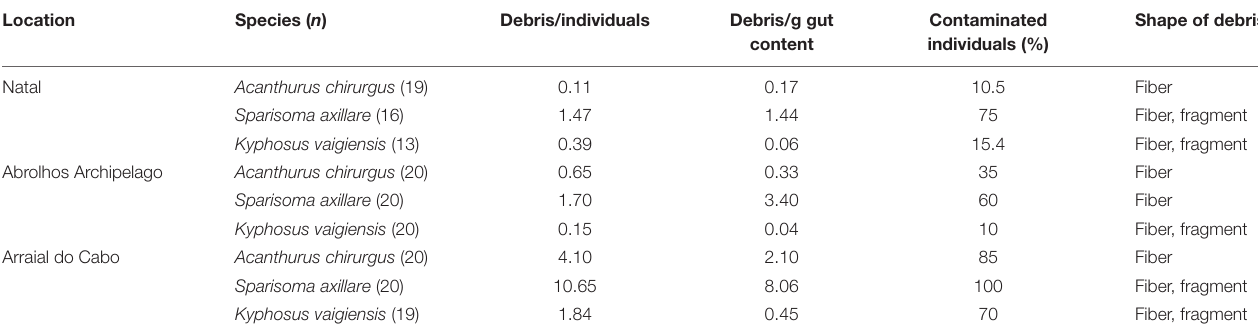
TABLE 3 | Parameters estimates for the final zero-inflated Poisson generalized linear model for the association between traits of reef fishes, location, and number of debris ingested as the response variable.